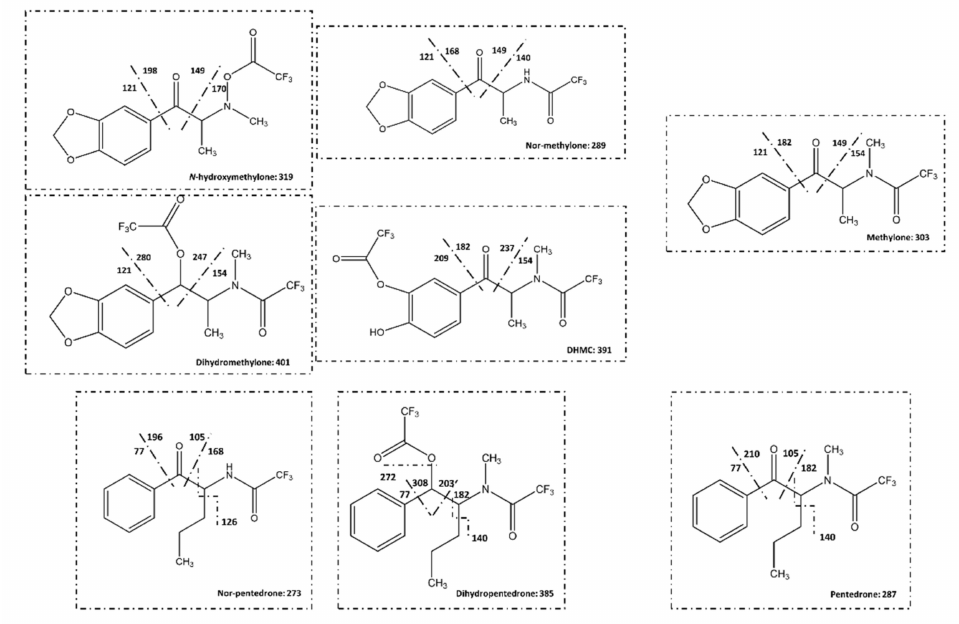
Figure 11. Mass fragmentation of methylone, pentedrone, and their metabolites. DHMC: dihydrox-